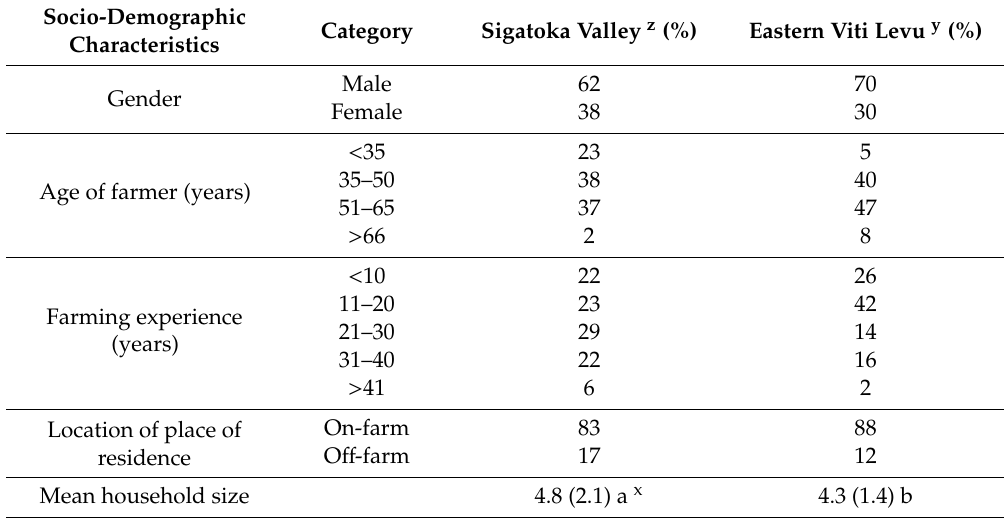
Table 1. Socio-demographics of Fijian tomato farmers in Sigatoka Valley and eastern Viti Levu.